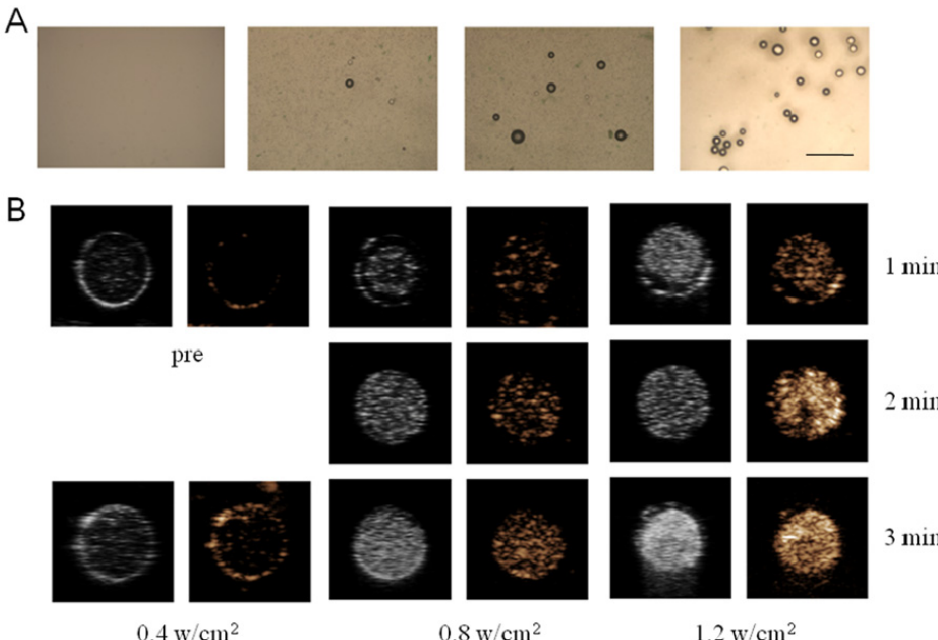
Figure 2. Phase transformation of nanoparticles triggered by LIFU: ( A ) Light microscope images of of nanoparticles under various LIFU irradiation. (scale bar = 50 µ m) ( B ) US images in B-mode and nanoparticles under various LIFU irradiation. (scale bar = 50 μ m) ( B ) US images in B-mode and CEUS mode of nanoparticles (5.0 mg/mL) before and after LIFU CEUS mode of nanoparticles (5.0 mg/mL) before and after LIFU irradiation.